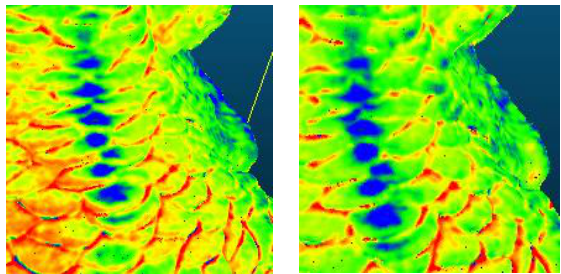
Figure 11: Region that mirror did not affect. Real object (left) and its reflection (right).